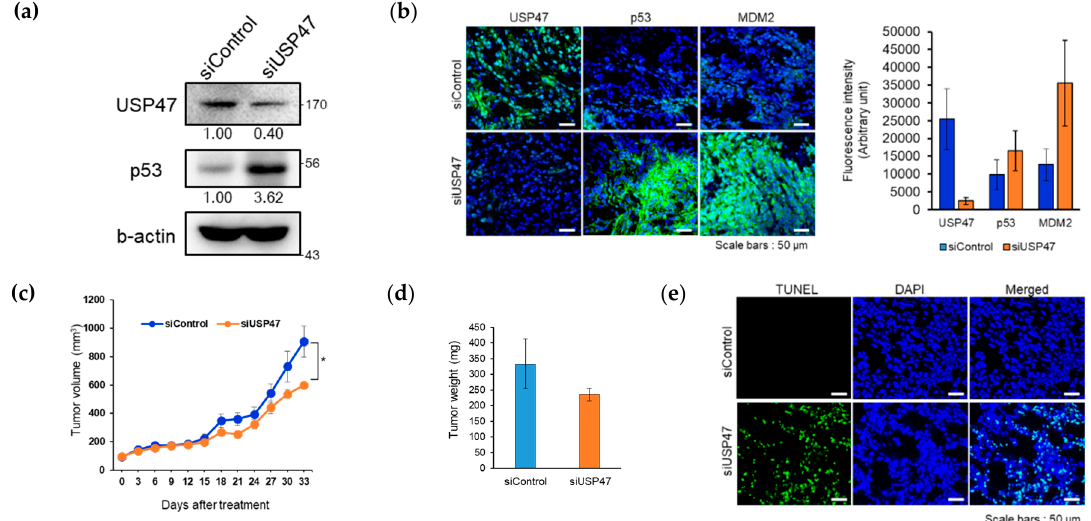
Figure 7. Suppression of USP47 inhibits cancer growth in vivo. ( a ) Western blot was conducted with tumor samples to evaluate the levels of USP47, p53, detected by indicated antibodies. ( b ) Immunofluorescence staining was conducted in dissected tumors to evaluate the levels of USP47, p53, MDM2 and detected by indicated antibodies. Immunofluorescence images were captured by confocal microscopy and quantified by ImageJ. Blue colors represent DAPI. Scale bars indicate 50 µ m. ( c–d ) The tumor growth curves after initial treatment were shown; 2 mg / kg of siControl and siUSP47 were intratumorally administered into A549 xenografts every 3 days for 2 weeks. Tumor volumes were measured every 3 days after initial treatment. * p < 0.5 ( N = 4). Tumor weights were measured. ( e ) TUNEL assay was performed in dissected tumors to detect apoptotic cells using an in situ cell death detection kit. Blue colors represent DAPI. Scale bars indicate 50 µ m. The uncropped blots and molecular weight markers are shown in Figure S7.